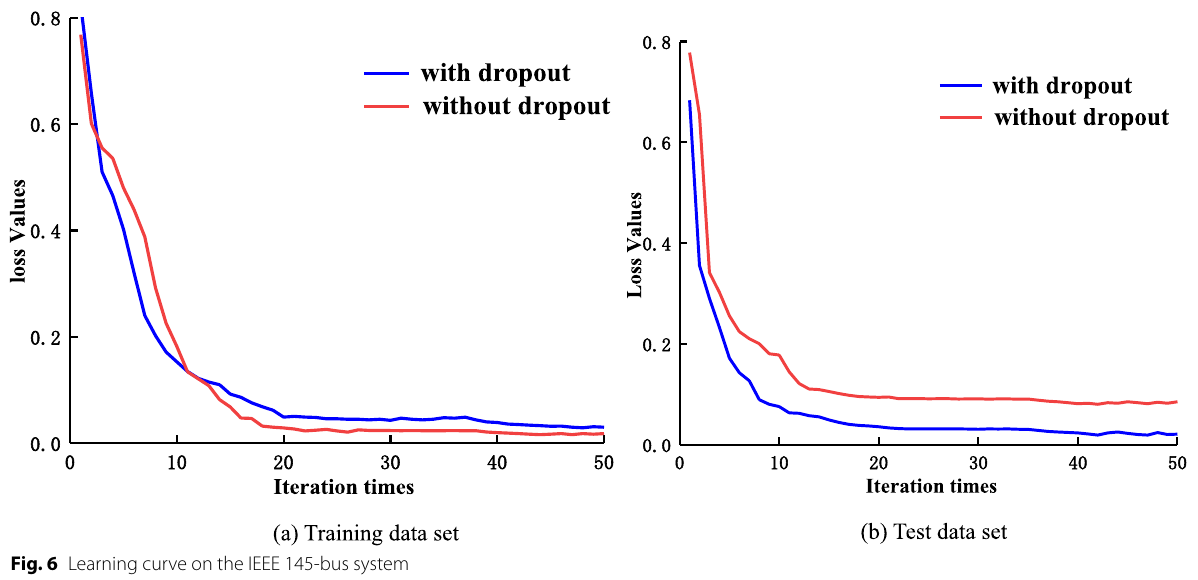
Fig. 6 Learning curve on the IEEE 145-bus system